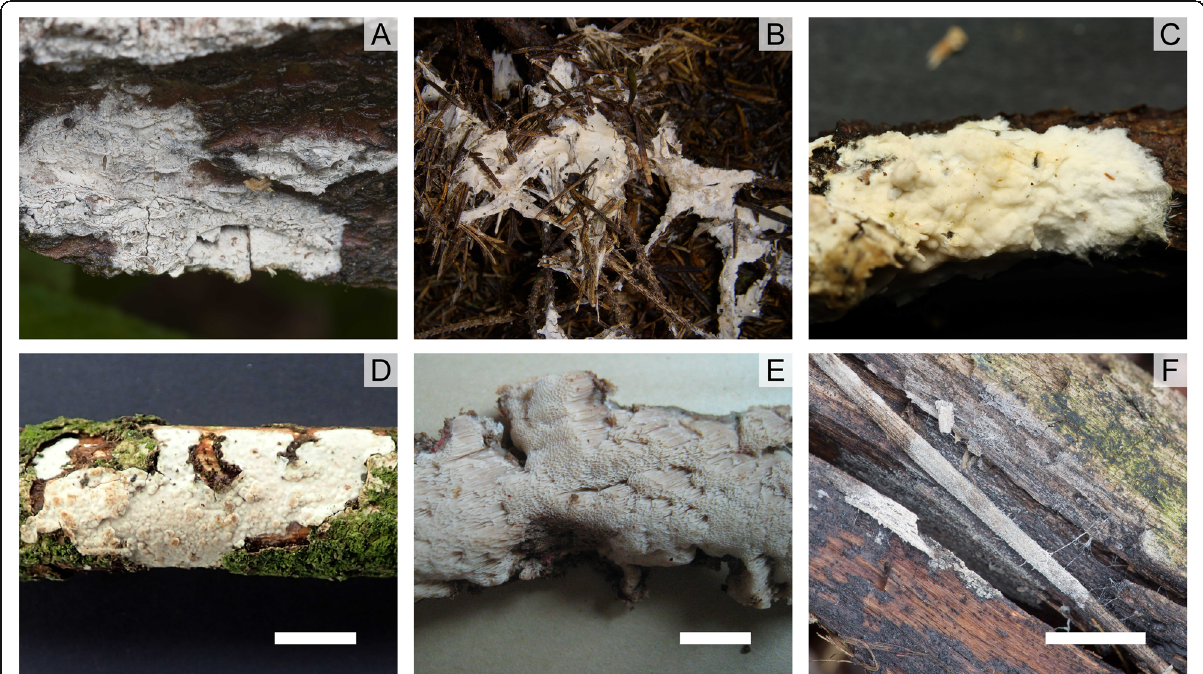
Fig. 2 Corticioid genera of Pterulaceae ( a-c ) and Radulomycetaceae ( d-f ). A : Coronicium alboglaucum *. b-c : Merulicium fusisporum *. d : Radulomyces confluens (ABS 53). e : Radulotubus resupinatus (Dai 15,315 – BJFC). f : Aphanobasidium cf. pseudotsugae (ABS 54). Photos kindly provided by L. Zíbarová ( a and f ), S. Blaser ( b and c ), D.J. Harries ( d ) and C.L. Zhao ( e ). Bars = 1 cm. * Samples not